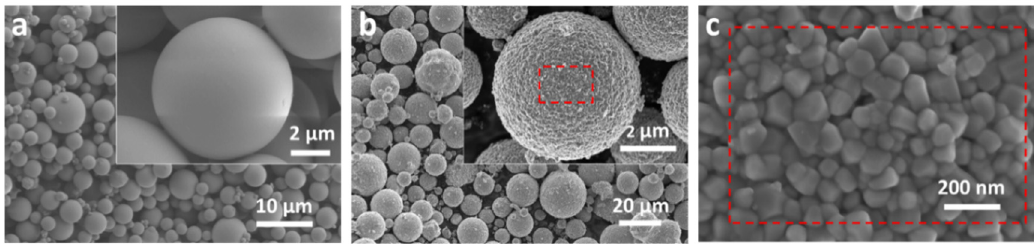
Figure 2. SEM micrographs of Cs 0.33 WO 3 , exhibiting morphology: ( a ) before and ( b ) after annealing, and ( c ) a magnified image for annealed sample.